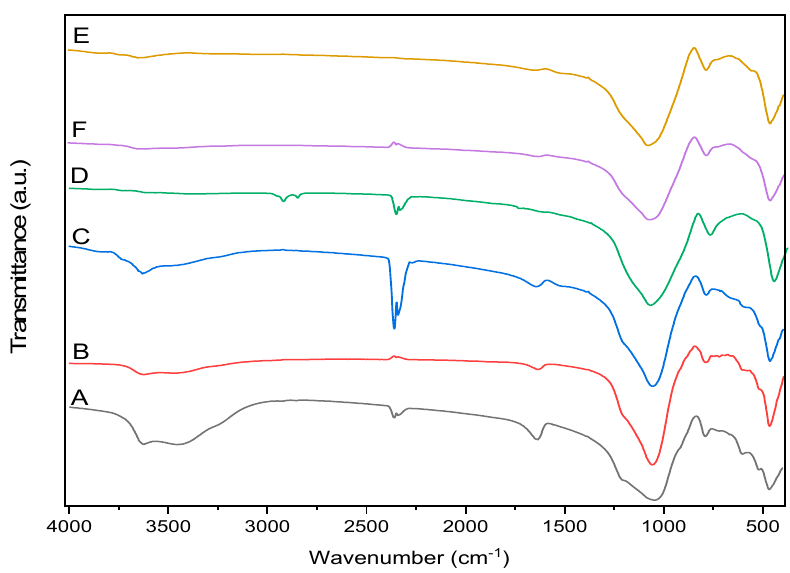
Figure 2. Fourier transform infrared (FT-IR) spectra of (A) raw zeolite (RZ), (B) zeolite thermally treated at 450 ◦ C, (C) zeolite thermally treated at 500 ◦ C, (D) zeolite thermally treated at 600 ◦ C, (E) zeolite thermally treated at 750 ◦ C, and (F) zeolite thermally treated at 800 ◦